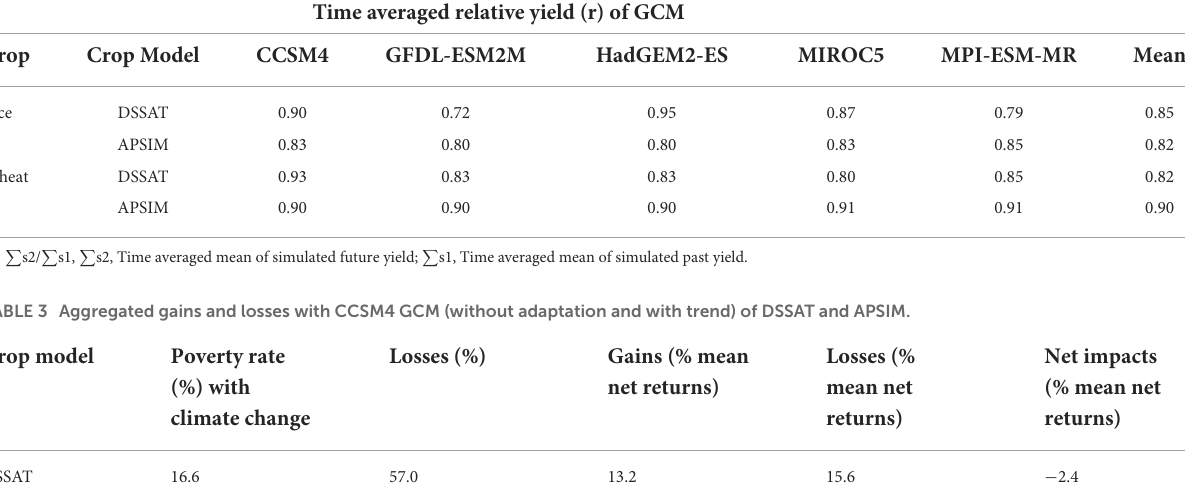
TABLE 2 Relative yield summary of crop models.